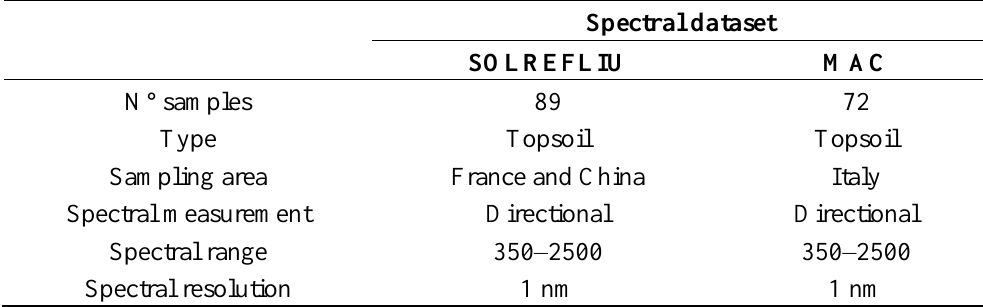
Table 1. Main characteristics of the MAC and SOLREFLIU spectral